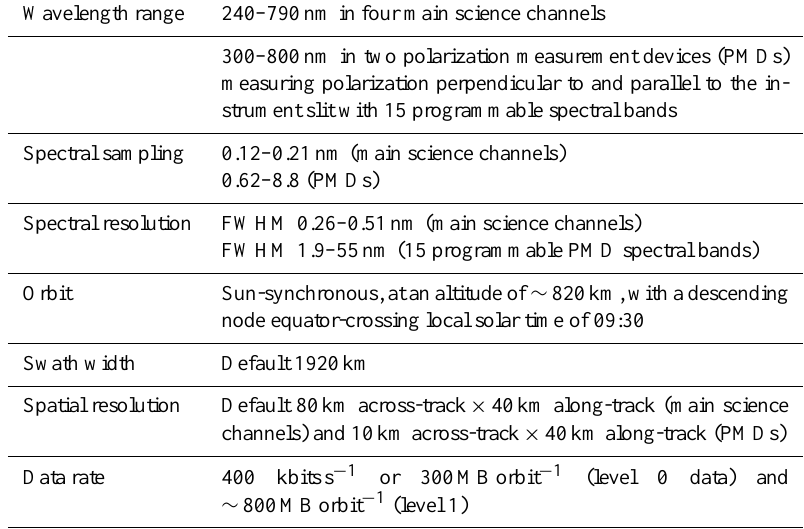
Table 1. Main GOME-2 instrument characteristics.